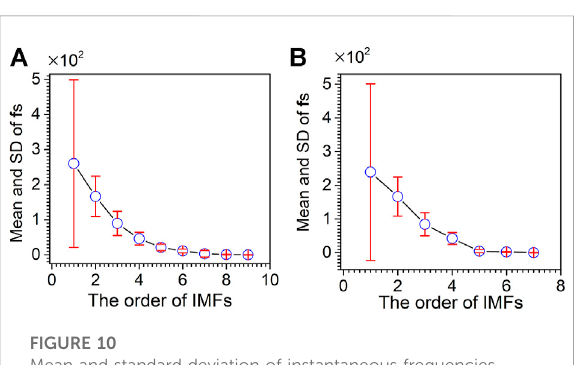
FIGURE 10 Mean and standard deviation of instantaneous frequencies for the XRD spectrum (A) and XPS spectrum (B) .